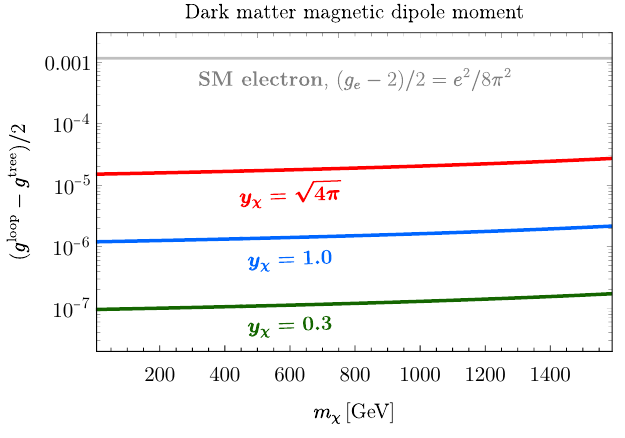
Figure 11 . One-loop dark matter magnetic dipole moment in benchmark BP1 ( m ϕ = 1.15 TeV and √ m ψ = 1.6 TeV) for y χ ∈ { 0.3, 1.0, 4 π } . The corresponding result for the electron [64, 65] is shown for